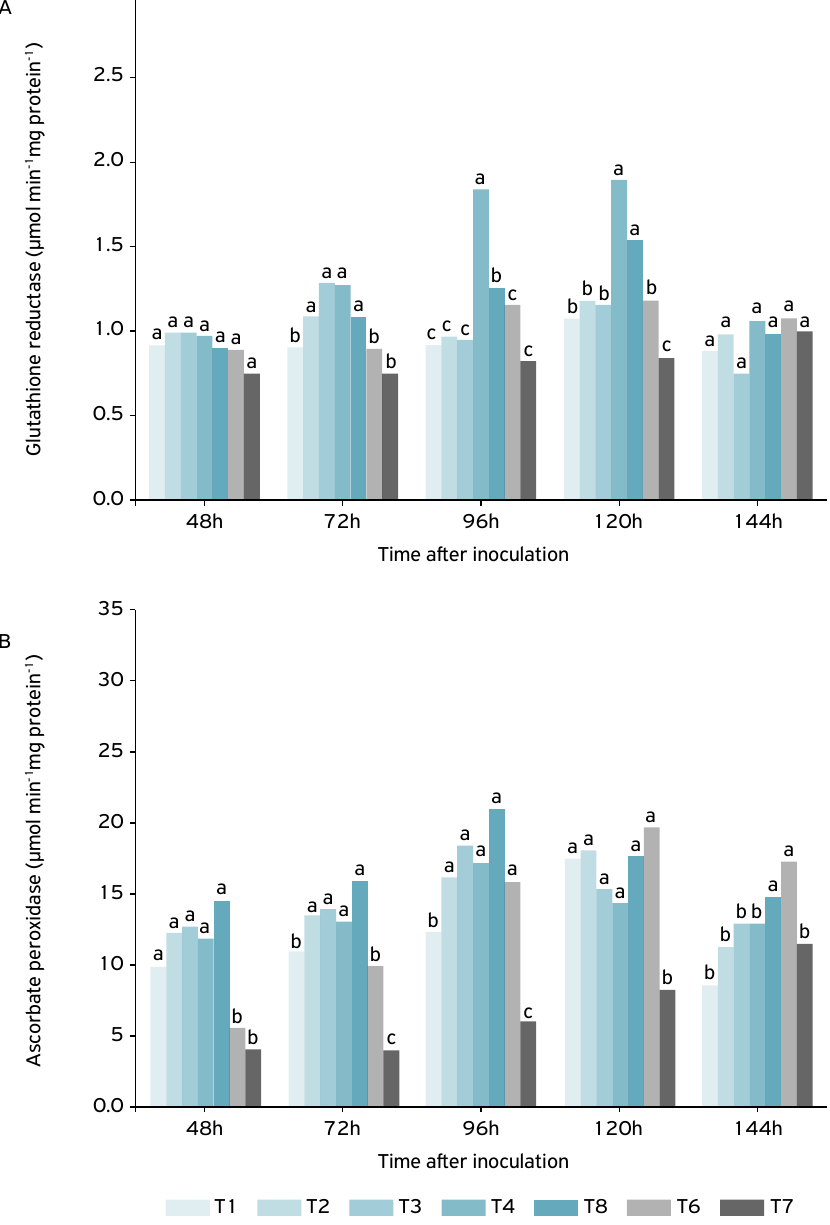
Figure 5. Activity of the enzymes (A) glutathione reductase and (B) ascorbate peroxidase, after inoculation of the Bipolaris sorokiniana